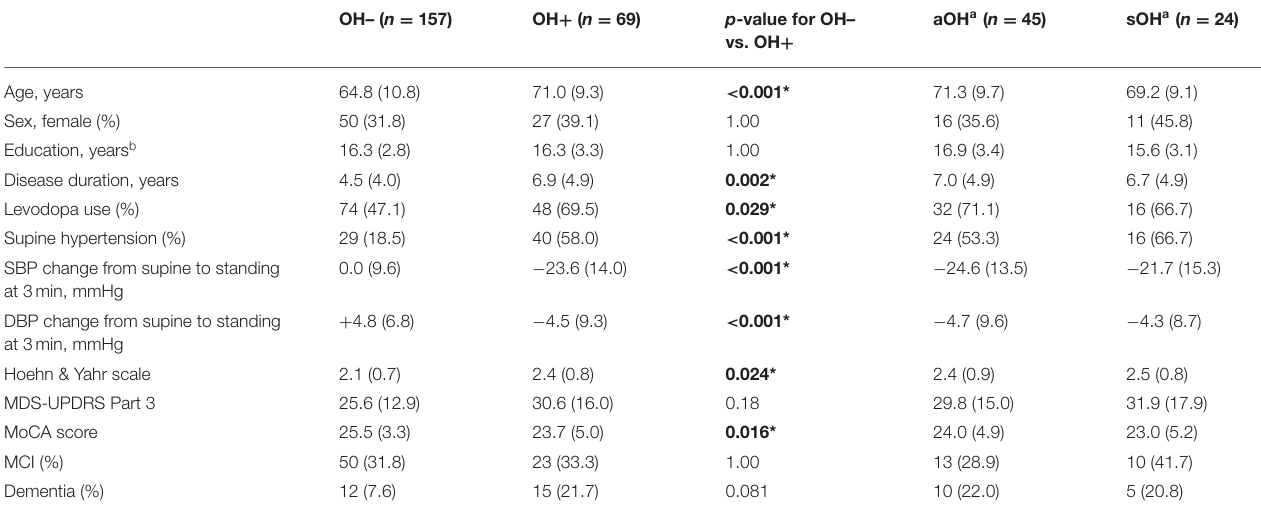
TABLE 1 | Cross-sectional comparison of clinical characteristics, demographics, and cognition between Parkinson disease patients with and without orthostatic hypotension (OH) and between patients with symptomatic OH and asymptomatic